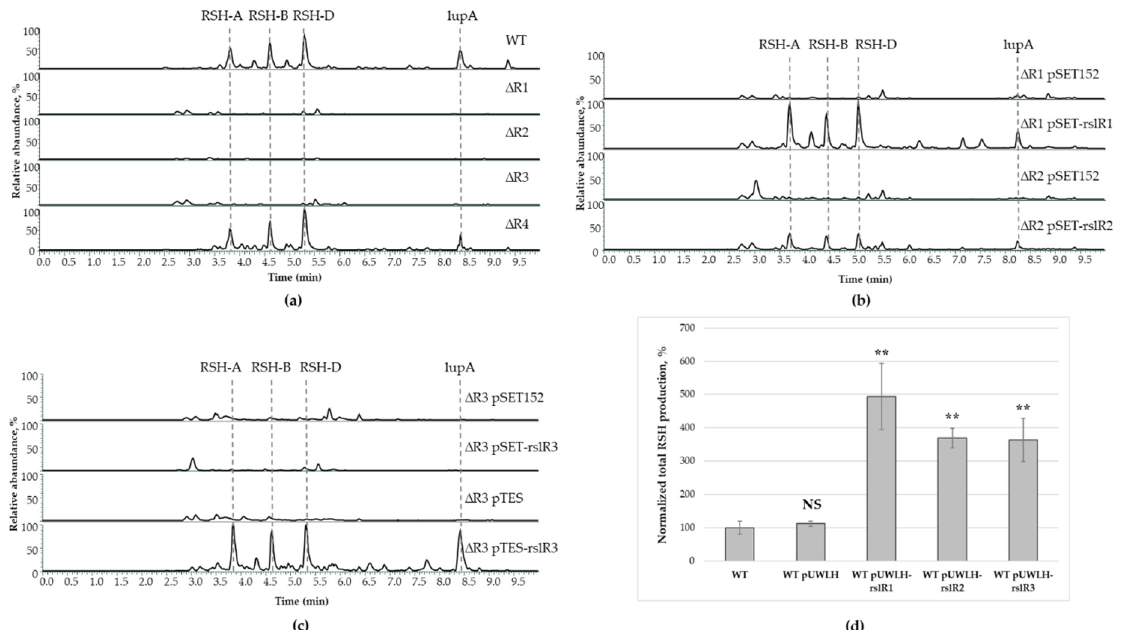
Figure 1. Rishirilides production by S. bottropensis strains. ( a ) UHPLC-MS analysis of culture extracts from S. bottropensis (WT) and mutant strains ( S. bottropensis ∆ R1, ∆ R2, ∆ R3, and ∆ R4); ( b ) UHPLC-MS analysis of culture extracts from complemented rslR1, rslR2 and ( c ) rslR3 mutant strains. Strains carrying the empty vector pSET152 or pTES were used as a control. ( d ) Levels of total rishirilide (RSH) production by the wild type and strains which overexpress regulatory genes. The mean value of total rishirilide production in S. bottropensis (WT) and S. bottropensis pUWLH (WT pUWLH) was taken as 100%. Error bars represent standard deviations. Significant differences in total rishirilide production between S. bottropensis and strains overexpressing regulatory genes were calculated by a two-tailed t -test. Asterisks represent the significance value (* p < 0.05, ** p < 0.01), whereas NS refers to not-significant differences.